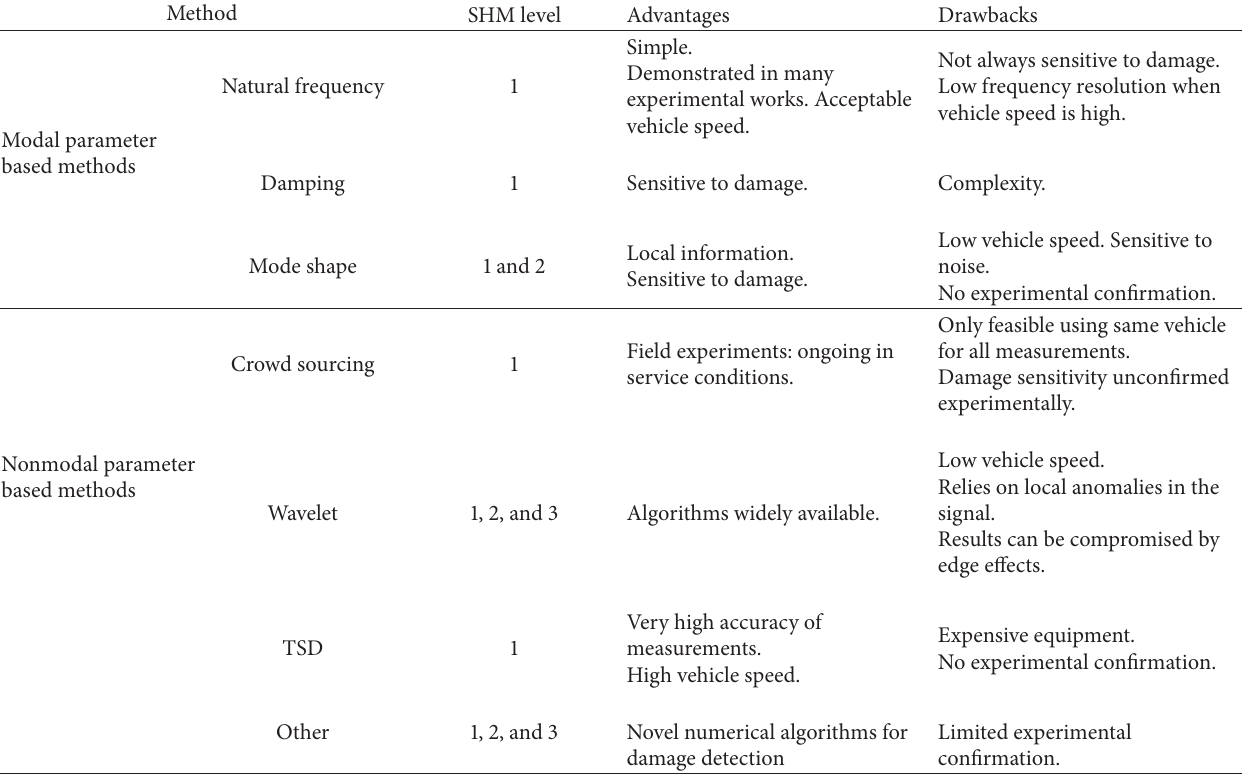
Table 1: Indirect bridge monitoring summary (SHM levels: 1 = detect existence of damage, 2 = detect damage location, and 3 = detect damage